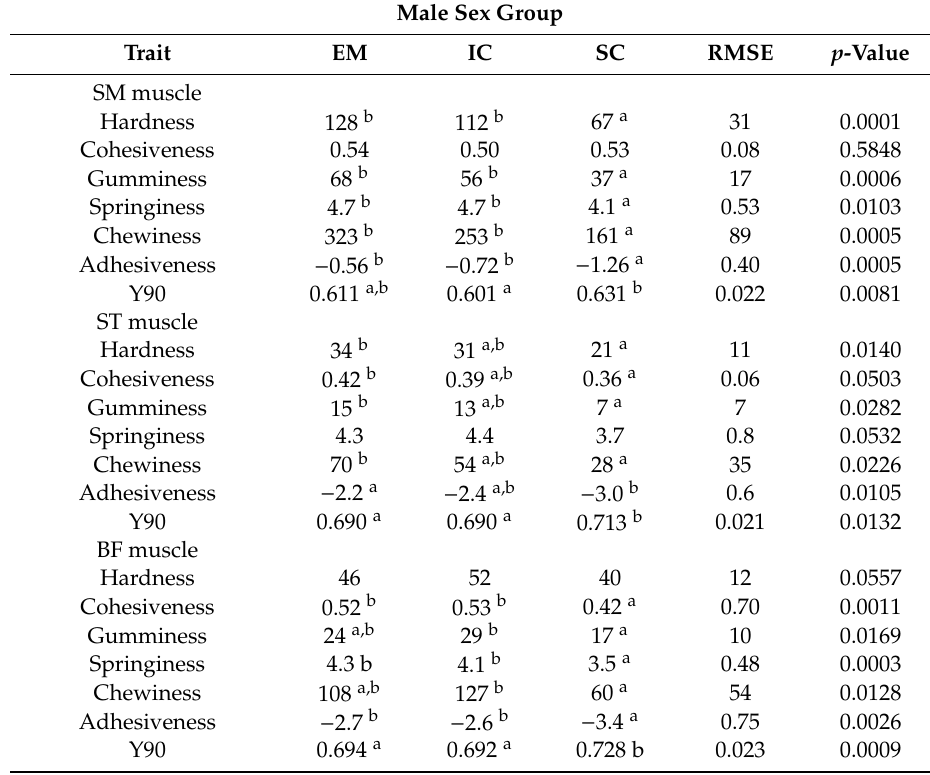
Table 3. E ff ect of male sex group on measurements of texture profile of dry-cured ham